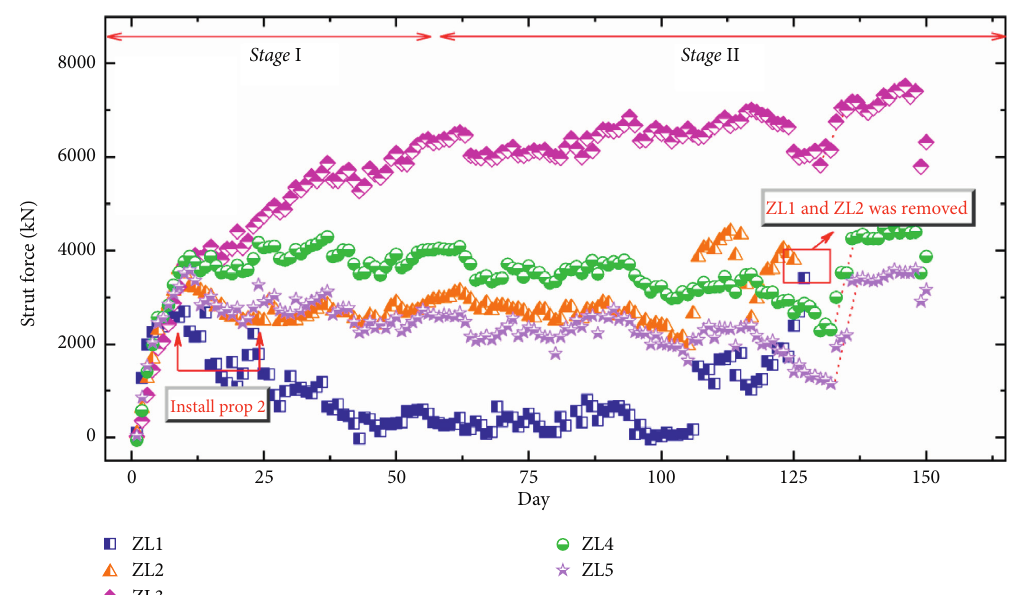
Figure 8: Variation law of the support axial